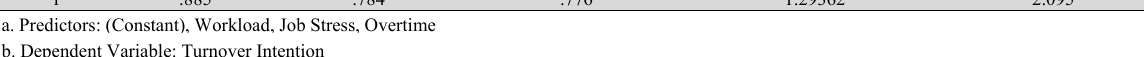
R Square Adjusted R Square Std. Error of the